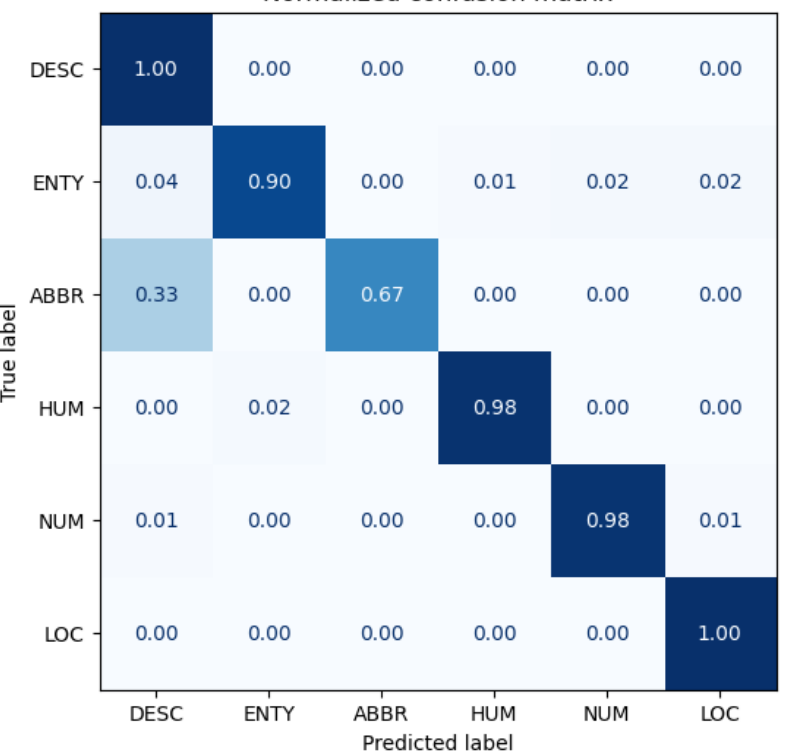
Figure A4. Antonym2 Run3 Confusion Matrix on TREC.